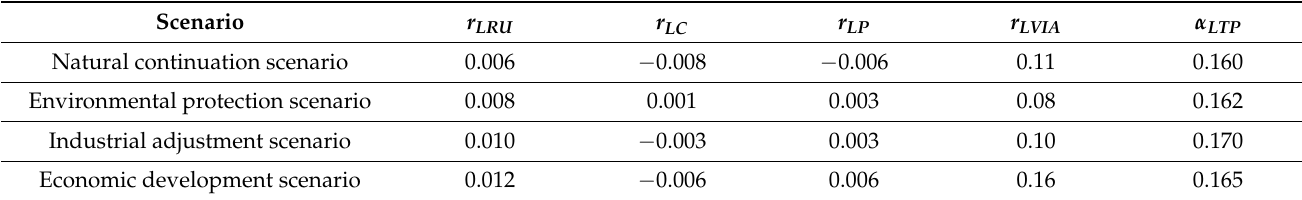
Table 7. Sensitive parameter values in the lower